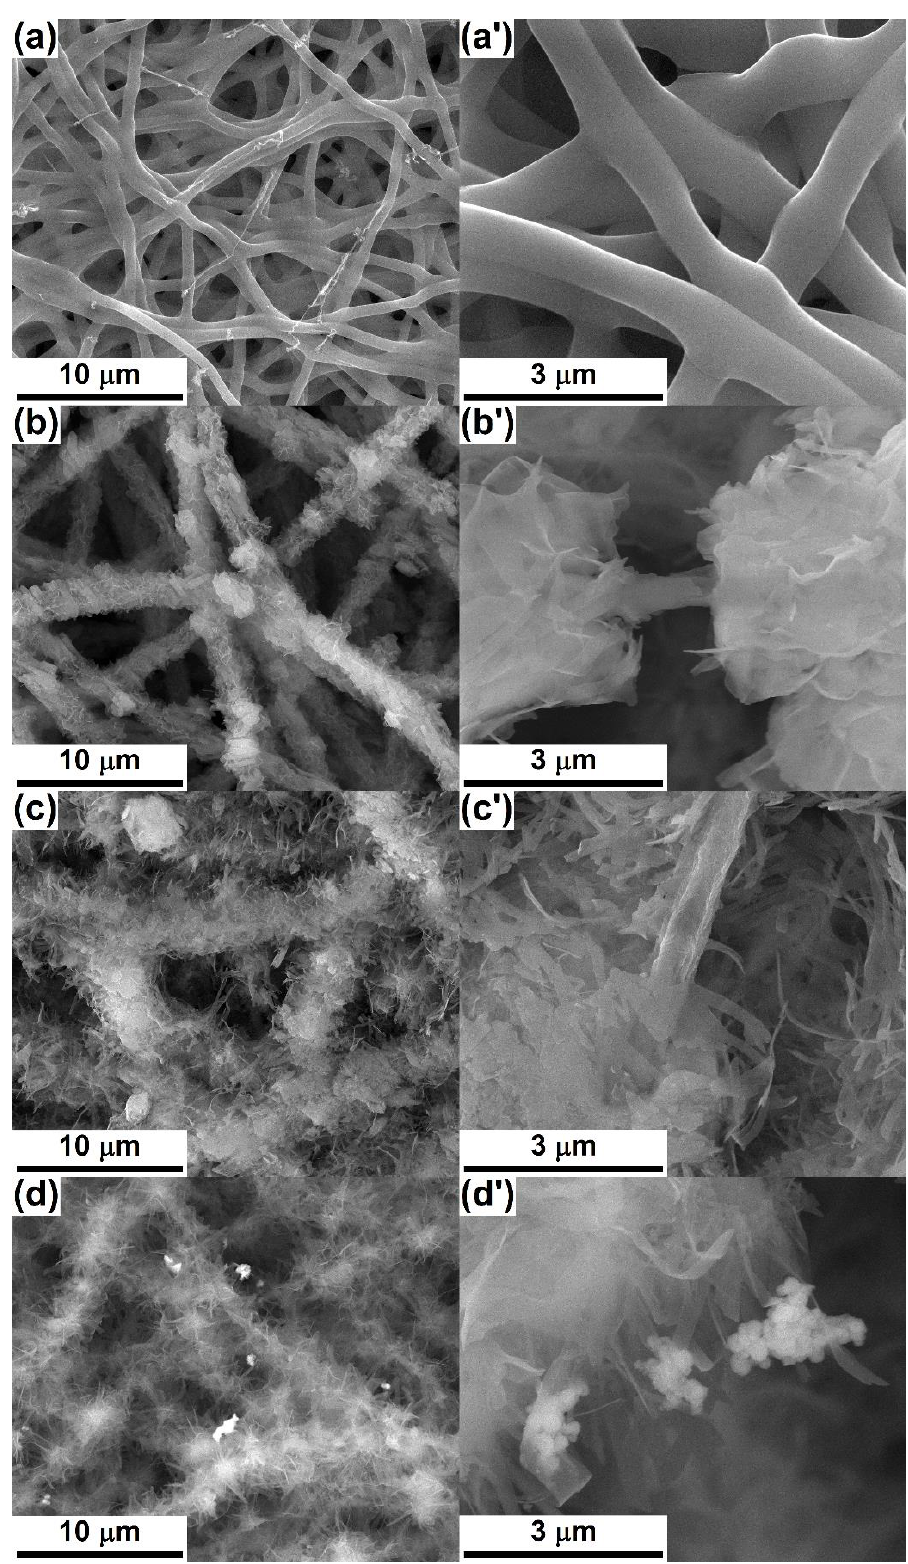
Figure 5. SEM images of: ( a , a ’) Gel fibre web, ( b , b ’) Gel -CPs-1c composite, ( c , c ’) Gel -CPs-3c composite and ( d , d ’) Gel